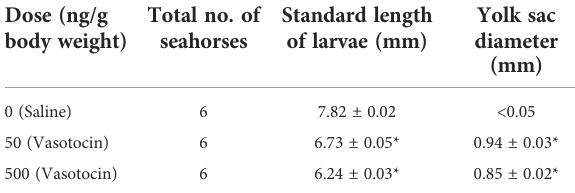
TABLE 3 Effect of the AVT hormone on parturition in the lined